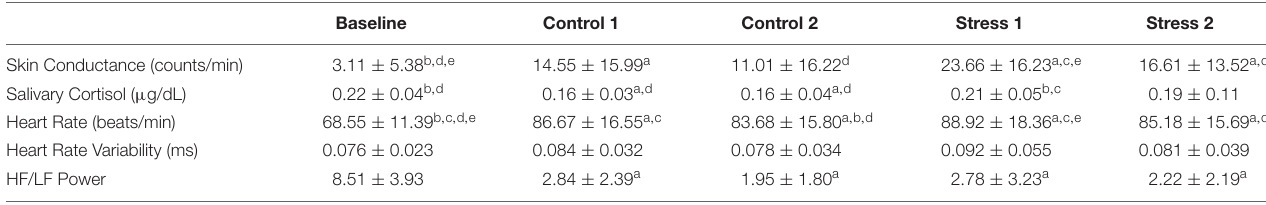
TABLE 1 | Physiological parameters [skin conductance, salivary cortisol, heart rate, heart rate variability, and the ratio of high frequency (HF) to low frequency (LF) band power] for all subjects during Baseline, Control conditions, and Stress conditions.